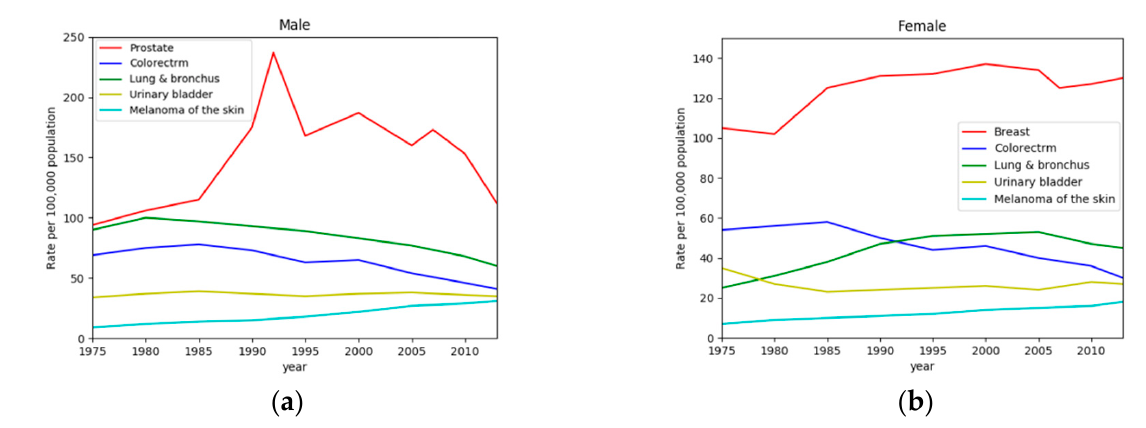
Figure 1. Trend of incidence rates for several cancers in the United States from 1975 to 2013. ( a ) and ( b ) present the trend on males and females, respectively.